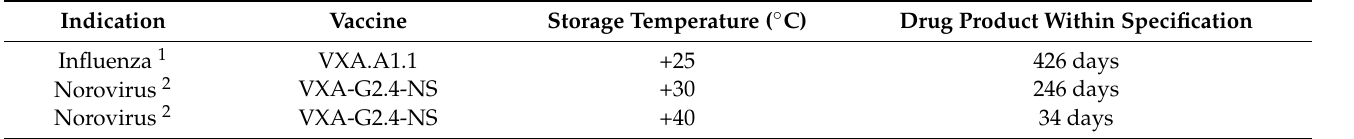
Table 1. Oral rAd5 vaccine tablet